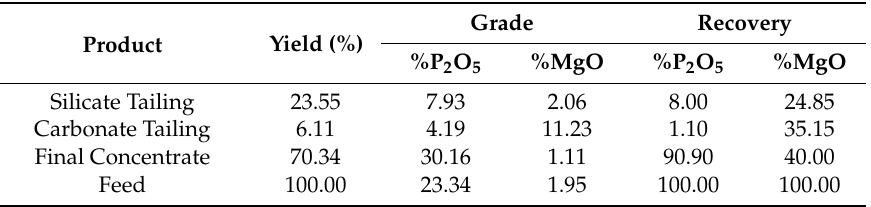
Table 9. Experimental results of closed circuit flotation.